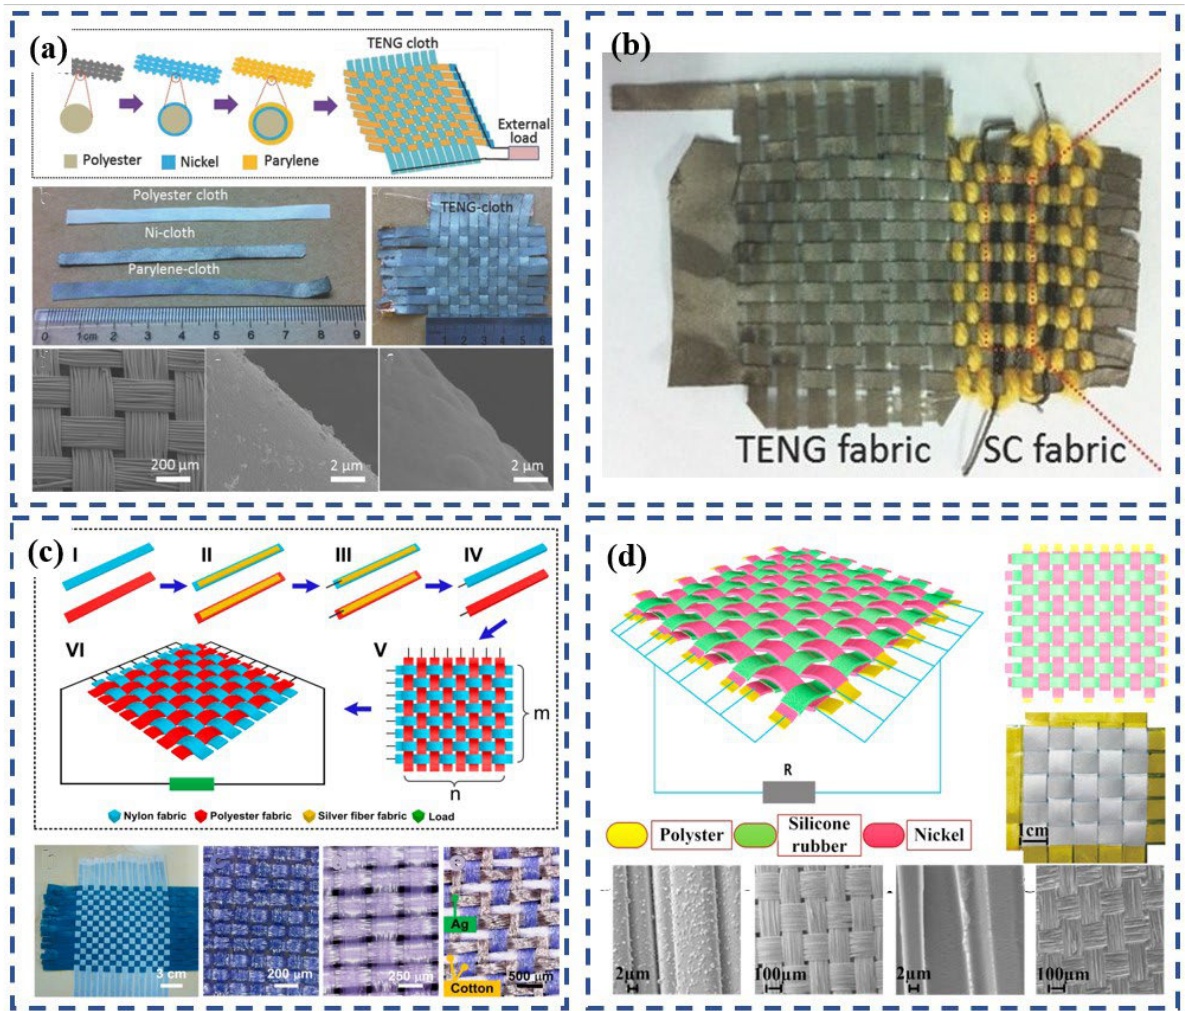
Figure 3. ( a ) TENG formed by using 10 Ni-coated polyester strips as longitude lines and 10 parylene- Ni-coated strips as latitude lines. Reproduced with permission [7]. Copyright 2015, John Wiley